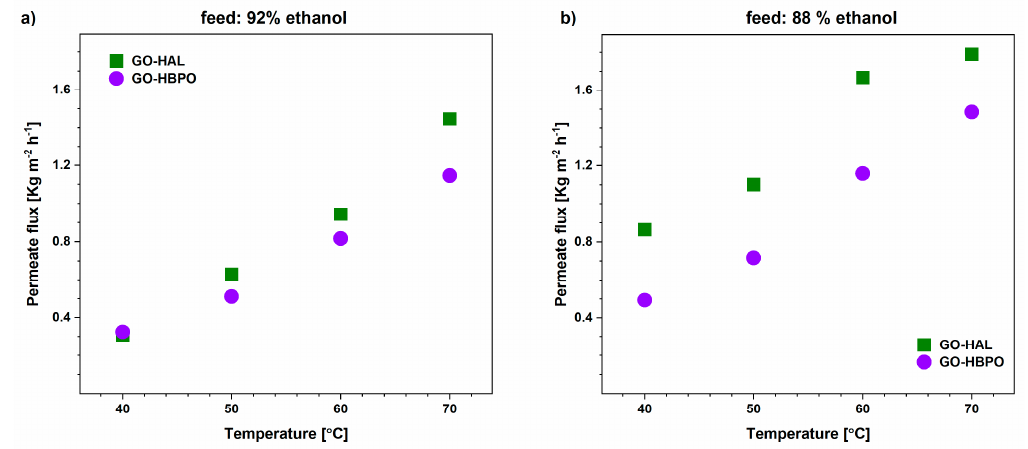
Figure 3. Total flux through GO-HAL and GO-HBPO as a function of the feed temperature for ethanol/water mixtures containing ( a ) 92% ethanol and ( b ) 88% ethanol.